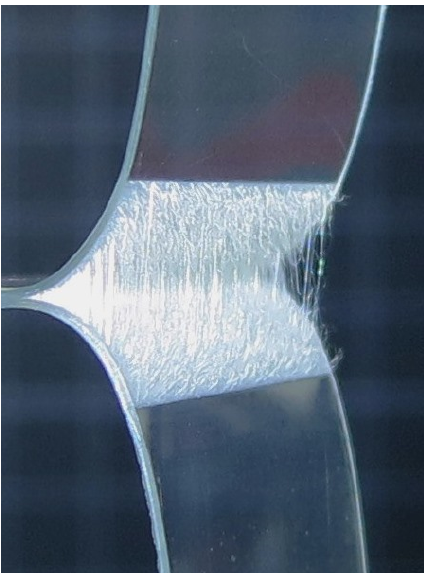
Figure 3 – The seal opening during the tensile strength test of material A. The test measures the force necessary to open the seal tearing apart the extremities of the